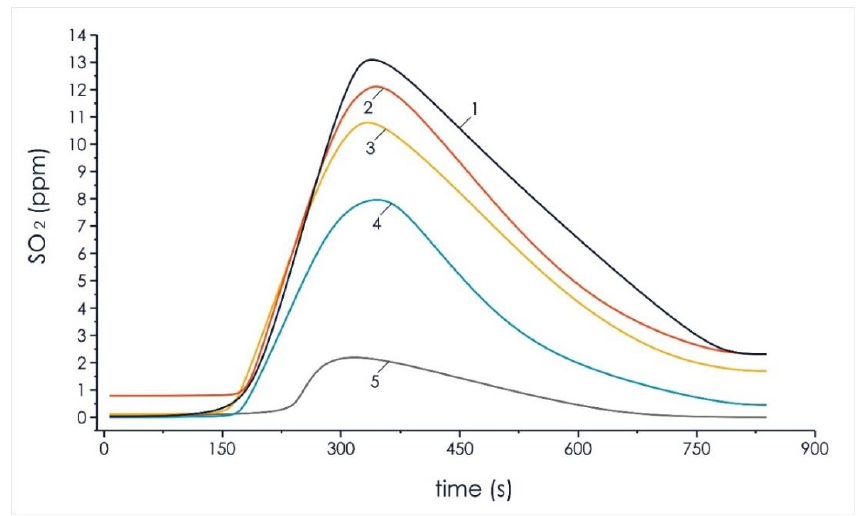
Figure 7. Analysis of sulfur oxides concentration in the composition of volatile flue gas compounds of the investigated pellets of the initial components and mixtures based on them: 1 — 100% coal; 2 — 90% coal, 10% cedar husk; 3 — 75% coal, 25% cedar husk; 4 — 50% coal, 50% cedar husk; and 5 — 100% cedar husk.